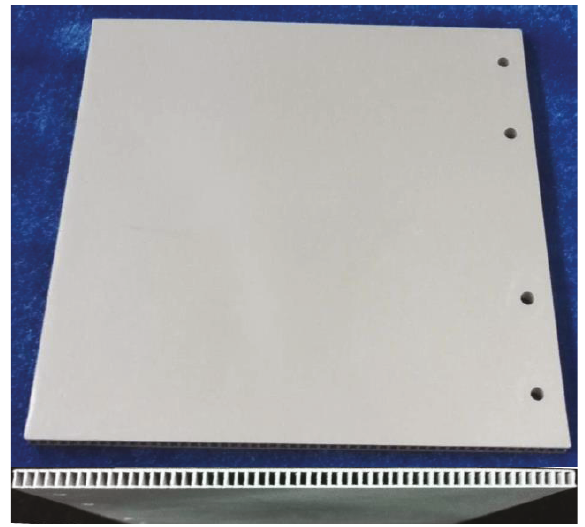
Figure 13: 3D metal printing of the new type of solar panel after Table 13: The analysis results of the relative deviation λ Performance